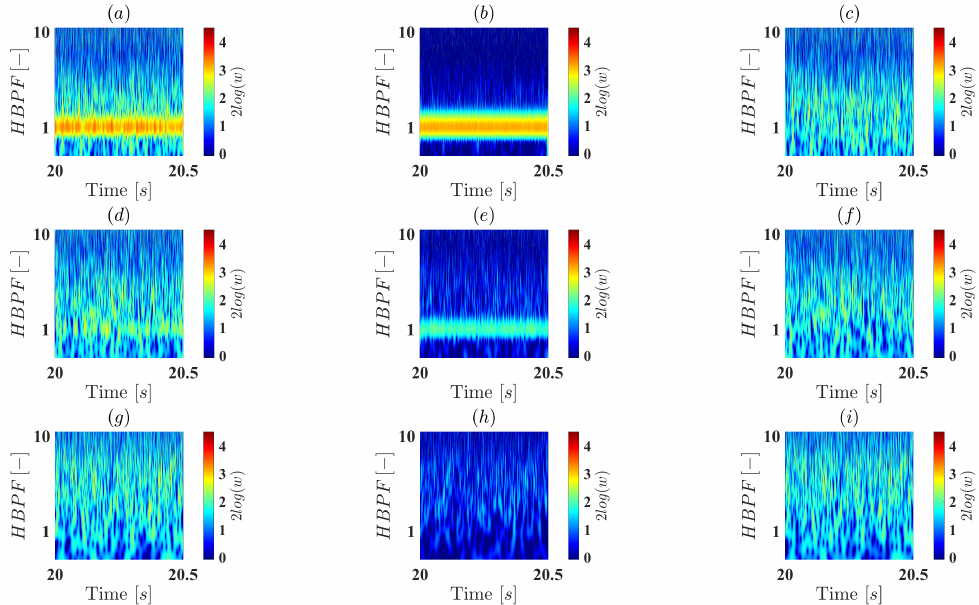
Figure 13. Wavelet intensity of the near-field pressure signal for the raw signal and the tonal and broadband components for each operational condition. ( a ) w ( p ) for the propulsive regime. ( b ) w ( p T ) for the propulsive regime. ( c ) w ( p BB ) for the propulsive regime. ( d ) w ( p ) for the transitional regime. ( e ) w ( p T ) for the transitional regime. ( f ) w ( p BB ) for the transitional regime. ( g ) w ( p ) for the regenerative condition. ( h ) w ( p T ) for the regenerative condition. ( i ) w ( p BB ) for the regenerative